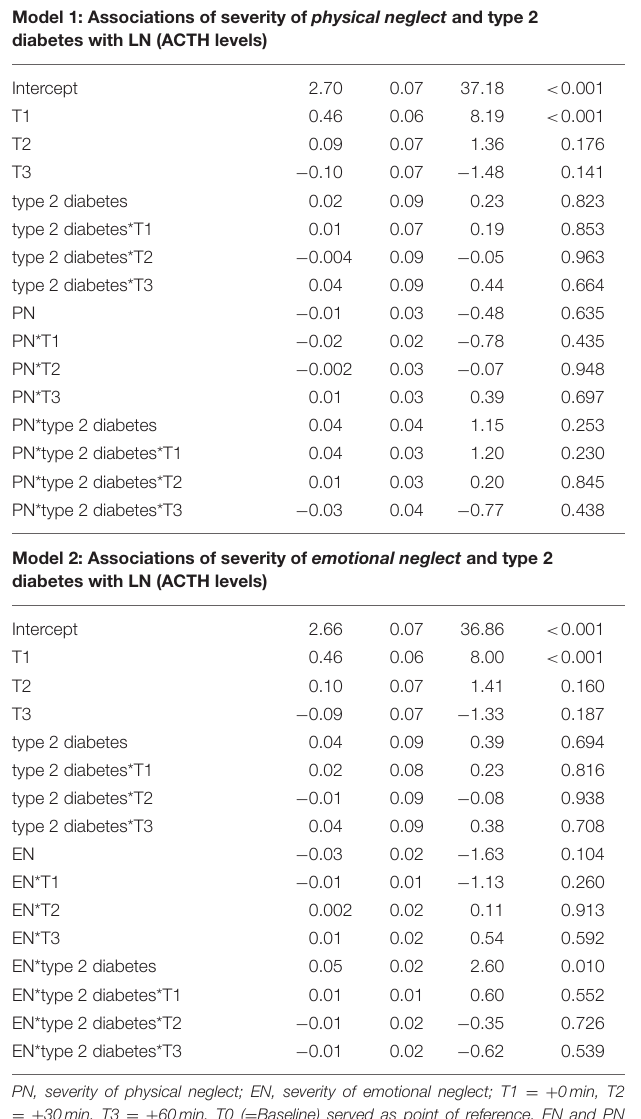
TABLE 4 | Multilevel models on plasma ACTH levels: estimates of fixed effects. Parameter Estimate Model 1: Associations of severity of physical neglect and type 2 diabetes with LN (ACTH levels) Intercept